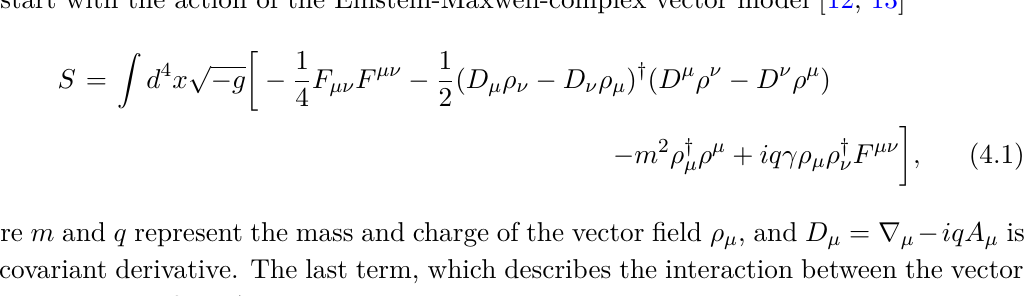
Figure 5 . Conductivity of the ( 2+1 )-dimensional s-wave superconductors for different values of the Gauss-Bonnet parameter with the fixed scalar field masses m 2 L 2 blue (solid) line and red (dashed) line represent the real part and imaginary part of the conductivity σ ( ω )